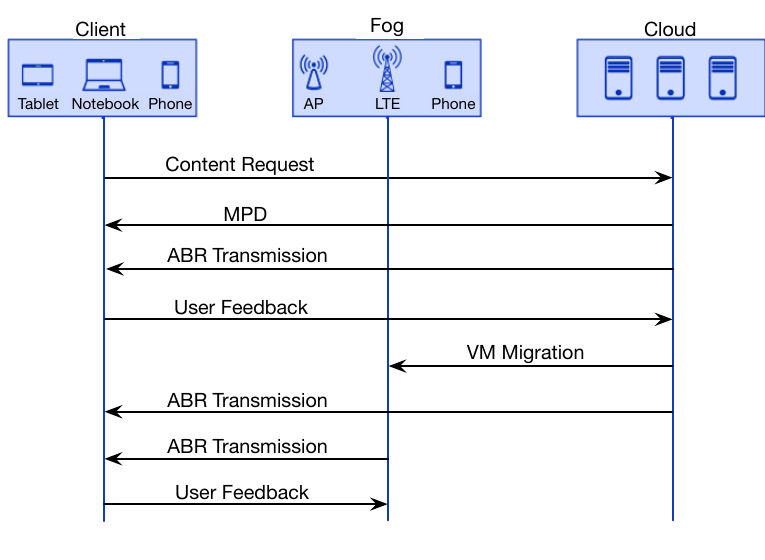
Figure 2. Video Service Migration to Multi-tier Fog